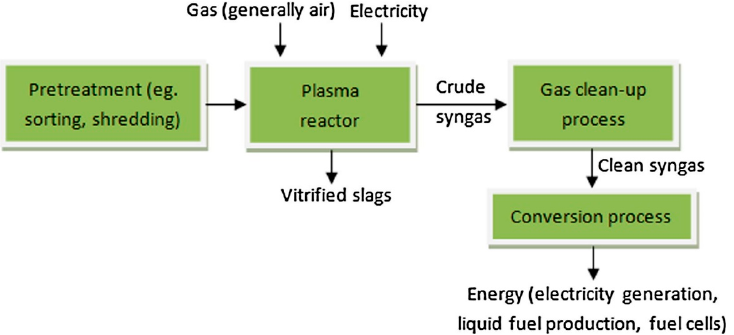
Figure 7. Flow chart of the plasma treatment of e-waste. Reprinted from [9] with permission from Elsevier 2016.